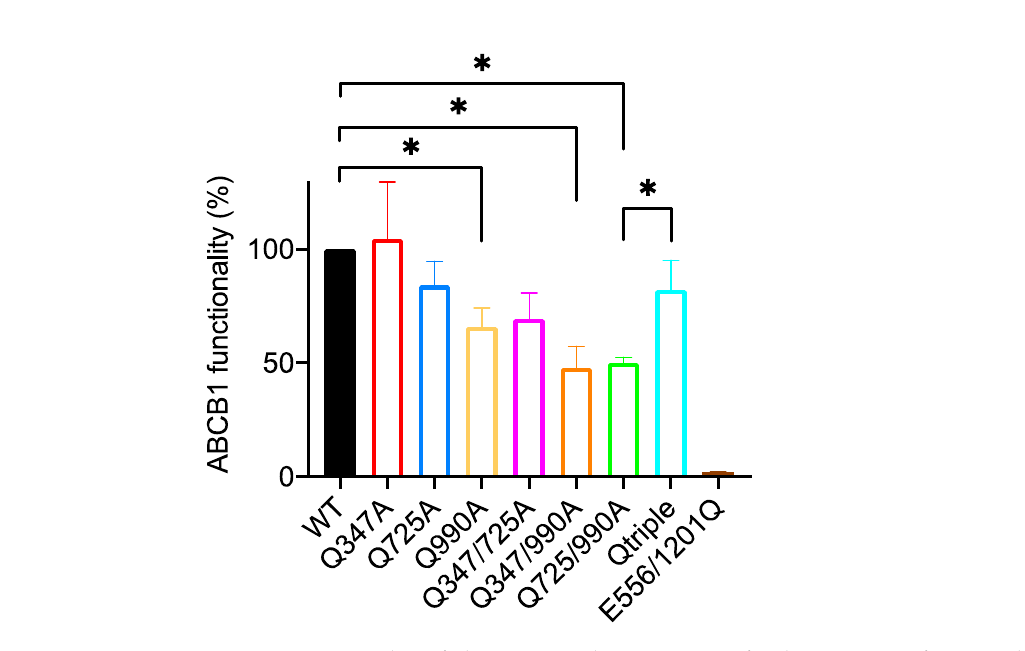
Figure 5. Functionality of glutamine to alanine mutants for the transport of OG-taxol. Live HEK293T cells transiently expressing equivalent amounts of wild-type (wt) and mutant ABCB1 were challenged with OG-taxol. Functionality was measured as the ratio of OG-taxol accumulation between the ABCB1-expressing and untransfected cells within the population. This was normalized to 100% for wild-type ABCB1 for the bar graph shown. The mean ± SEM was plotted using GraphPad Prism version 8; sample number was ≥ 3. Selected statistical analysis (unpaired Student’s t -test, two-tailed performed on the raw data except for the comparison of the wild-type with Q990A for which the raw data are paired) is shown with p value: * < 0.05. The full pairwise comparison of the data is given in Appendix A Table A3.